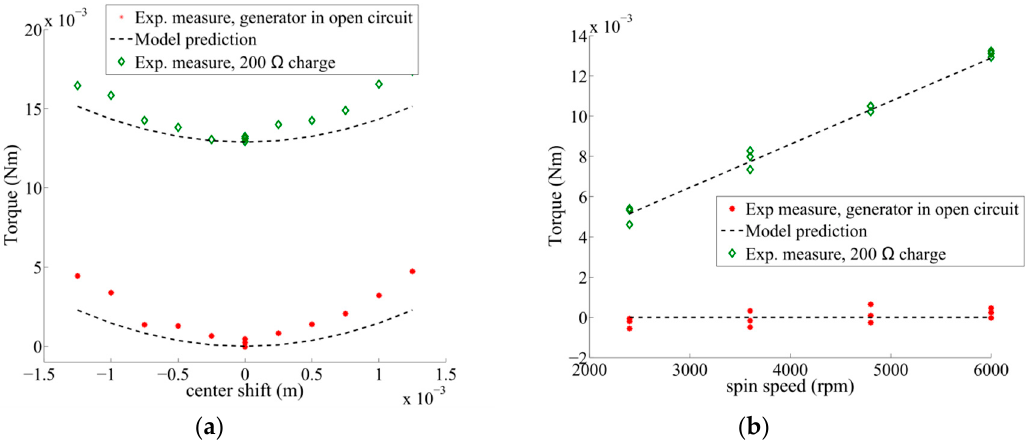
Figure 23. Measured and predicted torque without additional inductors ( a ) as a function of the rotor displacement along the x-axis, while centered along the y-axis for a spin speed of 6000 rpm and ( b ) as a function of the spin speed when the rotor is centered. Measures when the generator is left in open circuit and when connected to a 200 Ω charge.